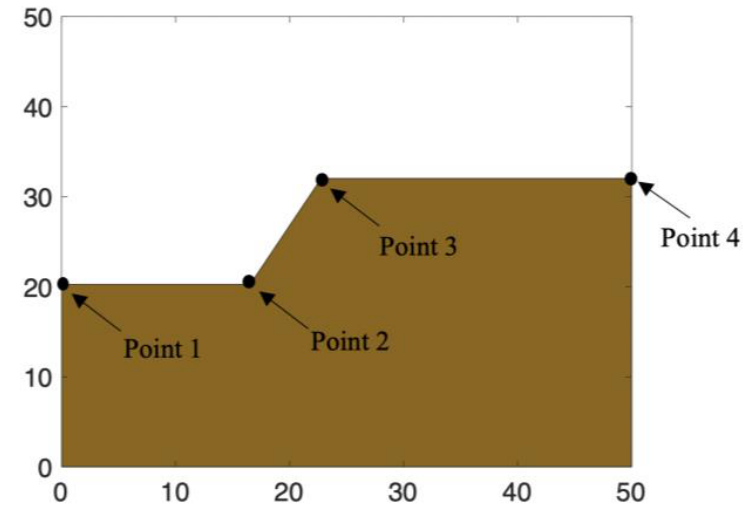
Figure 2. An example of the slope image data used in this study. The equations for producing the coordinates of these four points are listed in Table 2, where the random variable λ is a uniformly distributed value between 0 and 1. In addition to the equation, some restrictions were adopted to obtain slope geometries that were significantly different and could be conveniently analyzed with LEMs. First, the y coordinates of Point 1 and Point 2 were the same, meaning that the bottom of the slope was always horizontal. Second, the crown of the slope was also horizontal. Third, the slip circles could not extend beyond the dimensions of the image data (50 × 50). Fourth, the slip circles with radii of less than one were neglected, since they were susceptible to shallow failure. Fifth, in the calculation of the FS , it was assumed that the center of the slip circle ( x c , y c ) had the following attributes: 0 < x c < x 3 and y 3 < y c < y 3 + 15. These boundaries were then divided to form 30 grids in each direction, resulting in 900 slip circle centers for each image. Next, for each of these centers, 30 potential radii were tested to find the slip circle that could yield the minimum FS